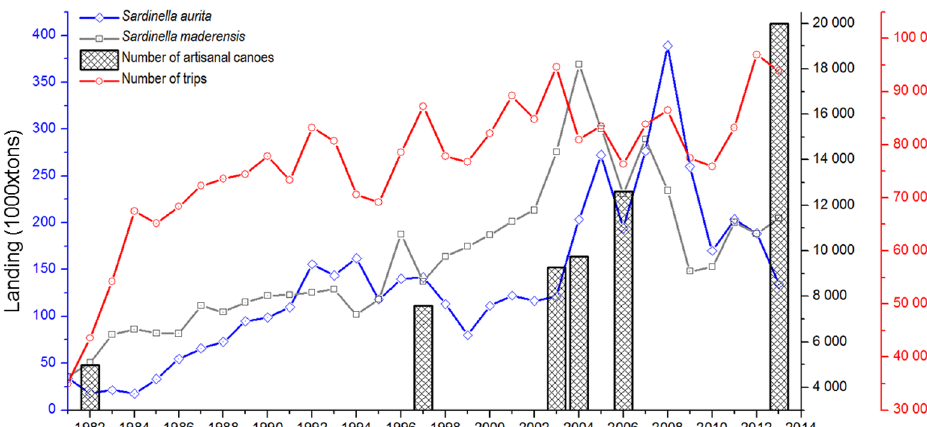
Fig. 1. Annual landing (tons) of Sardinella and fi shing effort for the small-scale fi shery in Senegal from 1981 to 2013. Landing of Sardinella aurita (blue line with lozenges) and S. maderensis (gray line with squares) and fi shing effort (red line with circles) were extracted from the CRODT database. The number of canoes for 1982, 1997, 2003, 2004 and 2006 were obtained from the FAO (2008) and for 2013 from Belhabib et al. (2014).